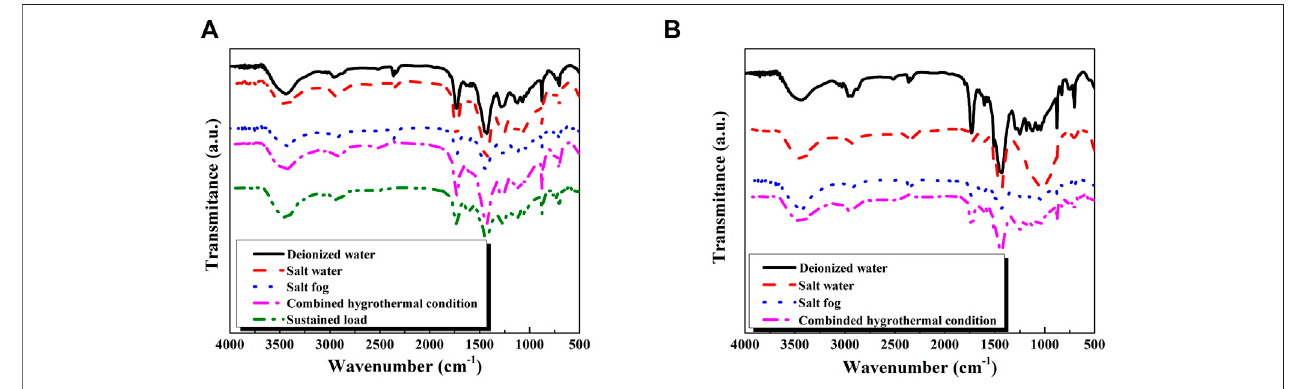
FIGURE 9 | FTIR spectra of pultruded GFRP composites under different exposure conditions after 180 days: (A) UP composite and (B) VE composite.